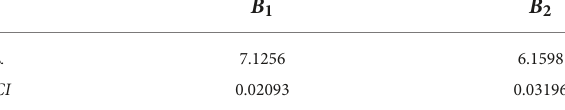
TABLE 6 Indicators of maximum eigenvalue and deviation consistency.